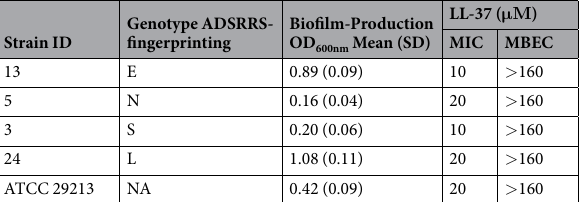
Table 1. Measurement of the bacterial susceptibility to the AMP LL-37 was determined by using a modified version of the Calgary Biofilm Device (CBD) method 59 . Minimum Inhibitory Concentration (MIC)